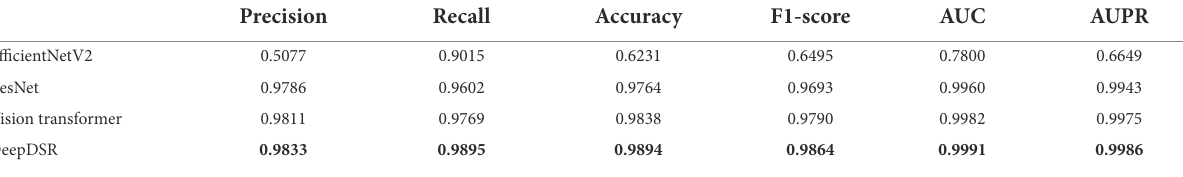
TABLE 3 The performance comparison of DeepDSR and other models for COVID-19 image binary classification. Precision